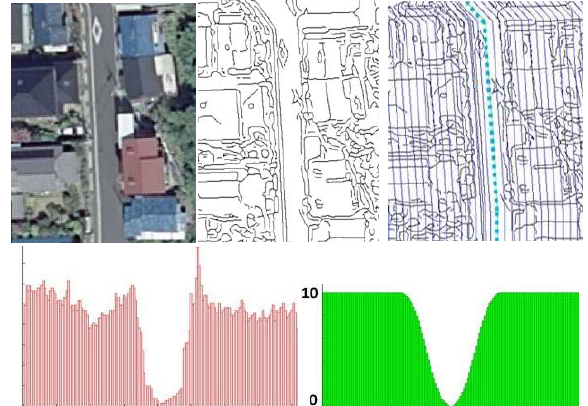
Figure 4: Strategy of edge direction analysis (extracted edges = black, expected road centreline = dotted cyan, parallel profiles = blue). Lower left: the computed histogram of the intersection counts over the profile index. Lower right: an optimal model